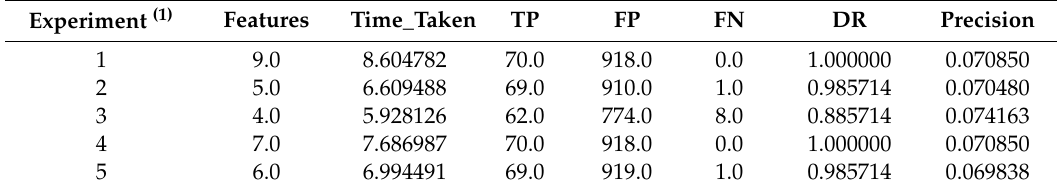
Table 5. LOF results with feature optimization. N_neighbors = 20 and contamination = auto. Experiment (1)